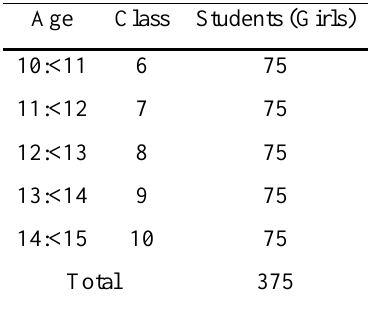
Table 1. Demographic characteristics of the student's